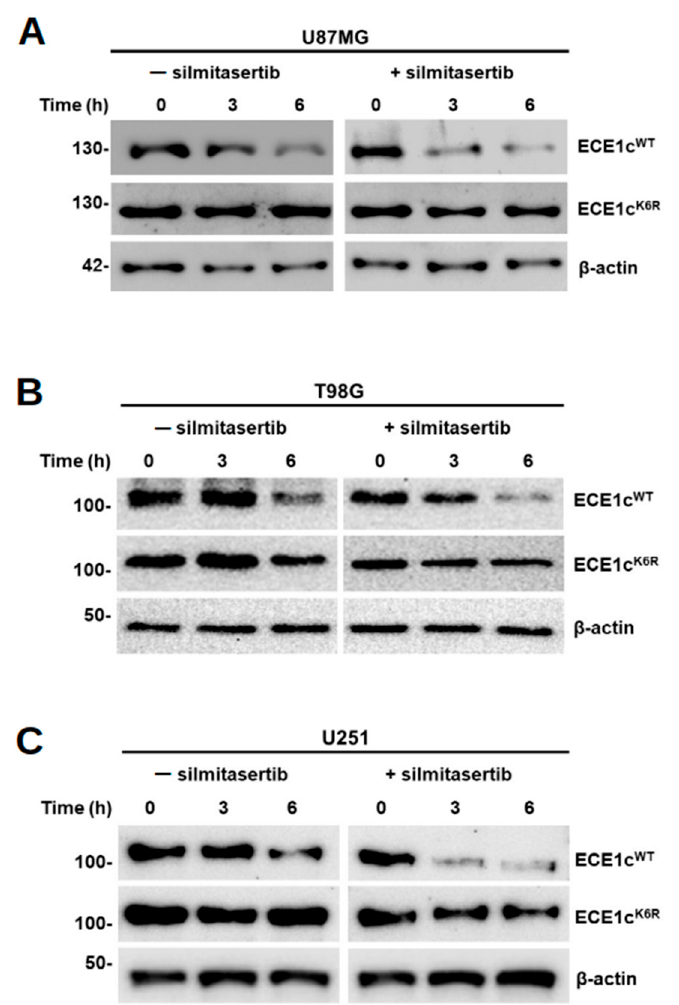
Figure 2. ECE1c K6R mutant was highly stable in GBM cells. Flag-tagged ECE1c WT - or ECE1c K6R -expressing U87MG ( A ), T98G ( B ), and U251 ( C ) cells were treated with 20 µ g/mL cycloheximide (CHX) in the absence or presence of 25 µ M silmitasertib for 6 h. ECE1c protein levels were evaluated using Western blots with an anti-Flag antibody, using β -actin as a loading control. Representative blots from three independent experiments are shown. Representative Western blots of ECE1c WT or ECE1c K6R and β -actin from three independent cell lines ( n = 3).